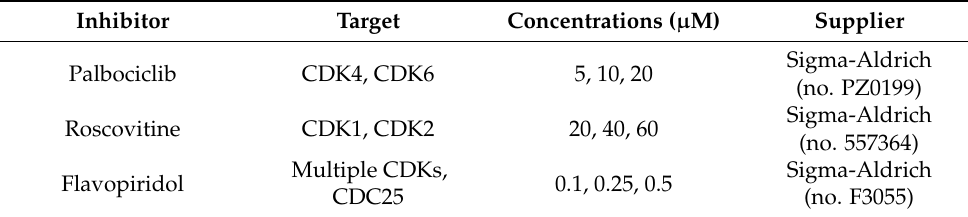
Table 4. Cell cycle